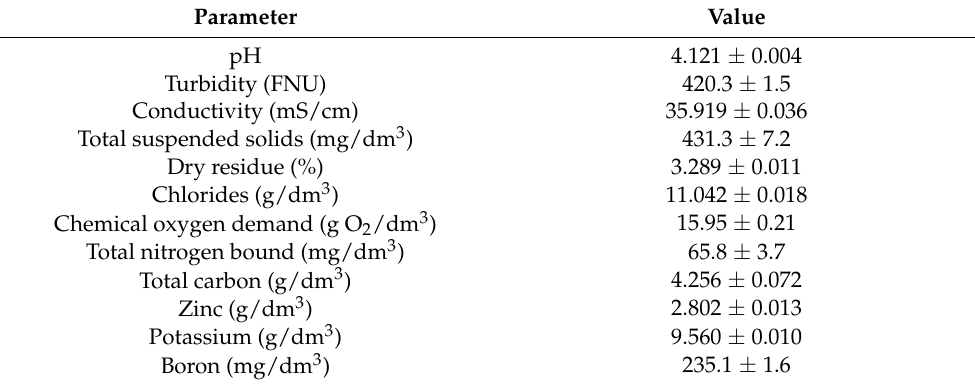
Table 2. Physical and chemical parameters of the galvanic